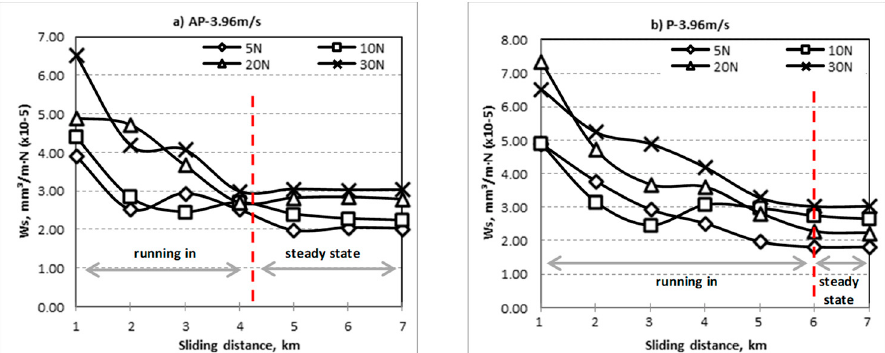
Figure 5. Specific wear rate vs. sliding distance for different fibre orientation (AP and P) subjected to difference of applied normal load at 2.83 m/s of sliding velocity.